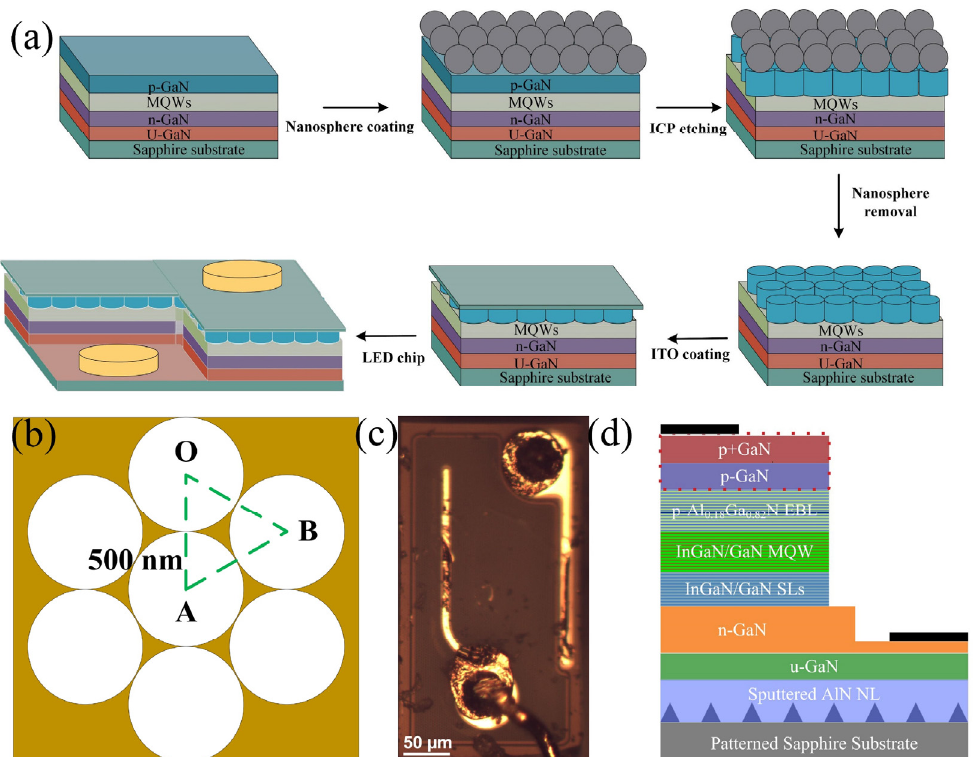
Figure 3. ( a ) Photolithography of SiO 2 nanospheres and fabrication of near ultraviolet LED devices; ( b ) Nanopore structure between p-GaN nanorods after ICP etching; ( c ) LED chip fabricated under optical microscope; ( d ) Epitaxial structure of LED devices.